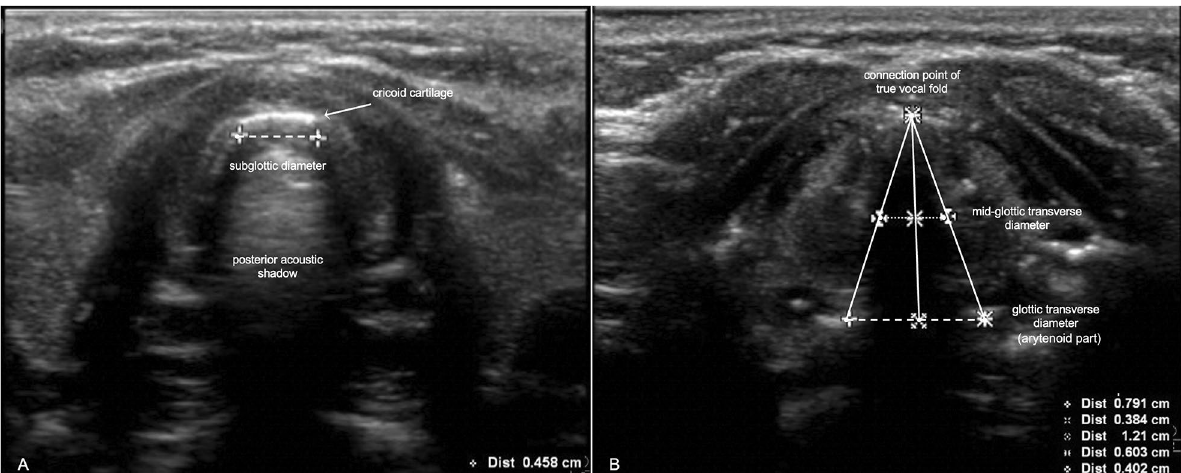
Figure 1. Subglottic diameter measurement ( A ), and glottic/mid-glottic transverse diameter measurement ( B